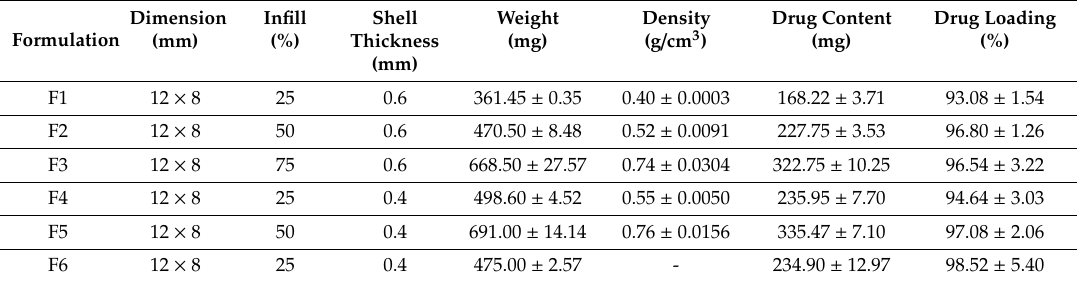
Table 3. Characteristics and evaluation of printed